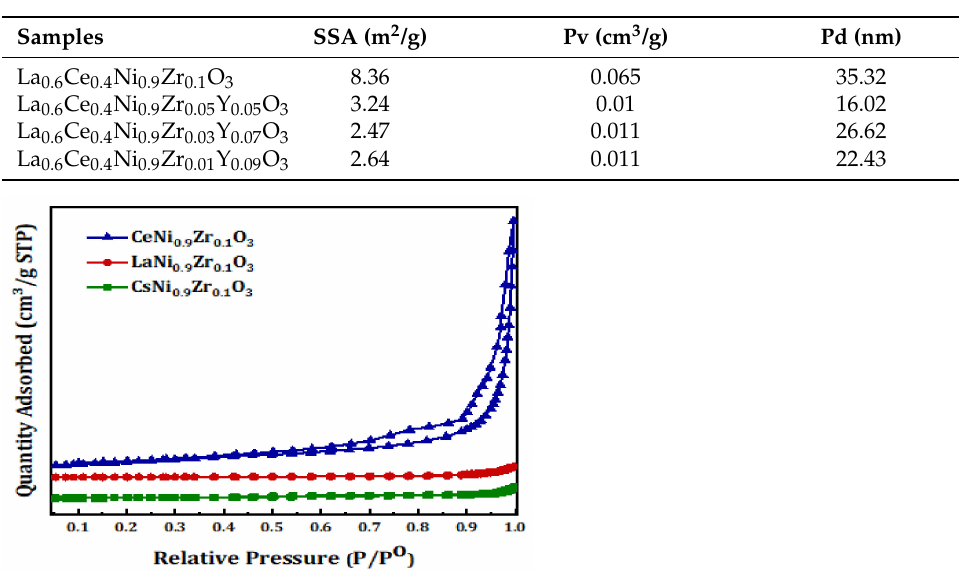
Table 2. Specific surface area (SSA), Pore volume (Pv) and Pore diameter (Pd) of the fresh cata- lyst samples.